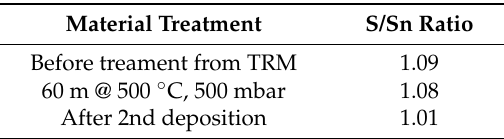
Table 2. The S/Sn ratio calculated from EDX measurement.